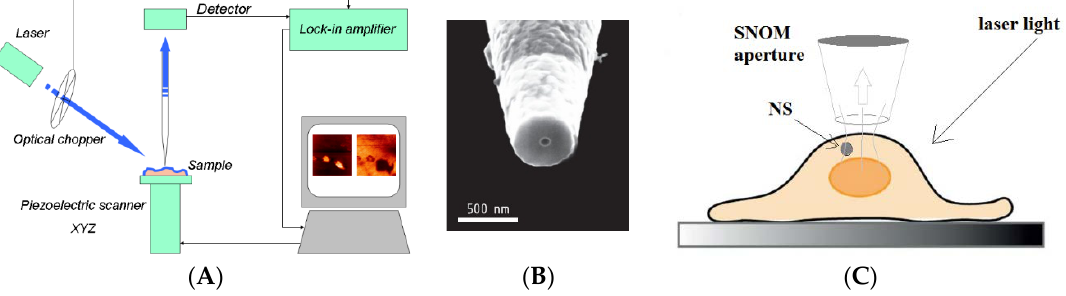
Figure 4. ( A ) Schematic sketch of a SNOM in collection mode; ( B ) detail of the SNOM probe; ( C ) Schematic sketch representing the physical description of dark-spot correspondent to AuNSs. The aperture SNOM is operating in collection mode, the laser light wavelength is 780 nm in order to exploit the infrared transparency window. During the scanning, when the SNOM probe is positioned in correspondence of the AuNS, the optical signal is strongly reduced. (Reprinted from [41] with permission).